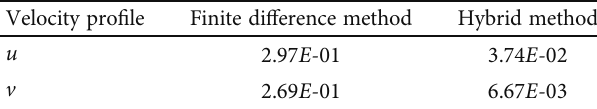
Table 5: Comparison of norm of relative error.